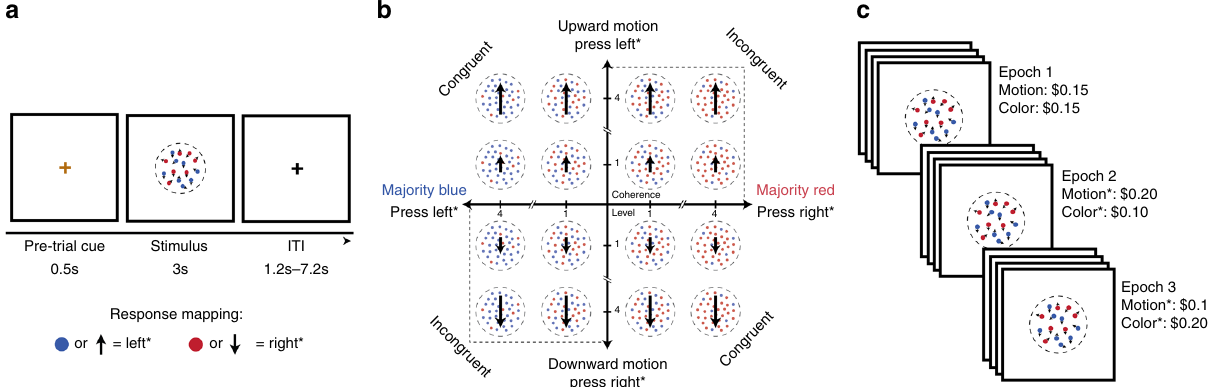
Fig. 1 Behavioral paradigm. a Participants viewed random dot motion patterns and could indicate whether the dots were primarily moving up or down and/ or whether they were majority red or blue. They responded with either a left or right button press. Responses were bivalent, denoting both a color and a motion direction, and participants were rewarded for each stimulus attribute they correctly discriminated on a given trial. b The coherence and correct response for motion and color dimensions were varied orthogonally across trials. Four participant-speci fi c coherence levels were used for each attribute. c Participants performed three epochs (192 trials each) that varied in motion/color reward associations, rewarding both either equally (Epoch 1) or differently (Epochs 2 and 3). Reward contingencies were explicitly indicated to the participants at the start of each epoch. *Response mappings and Epochs 2 and 3 reward associations were counter-balanced across